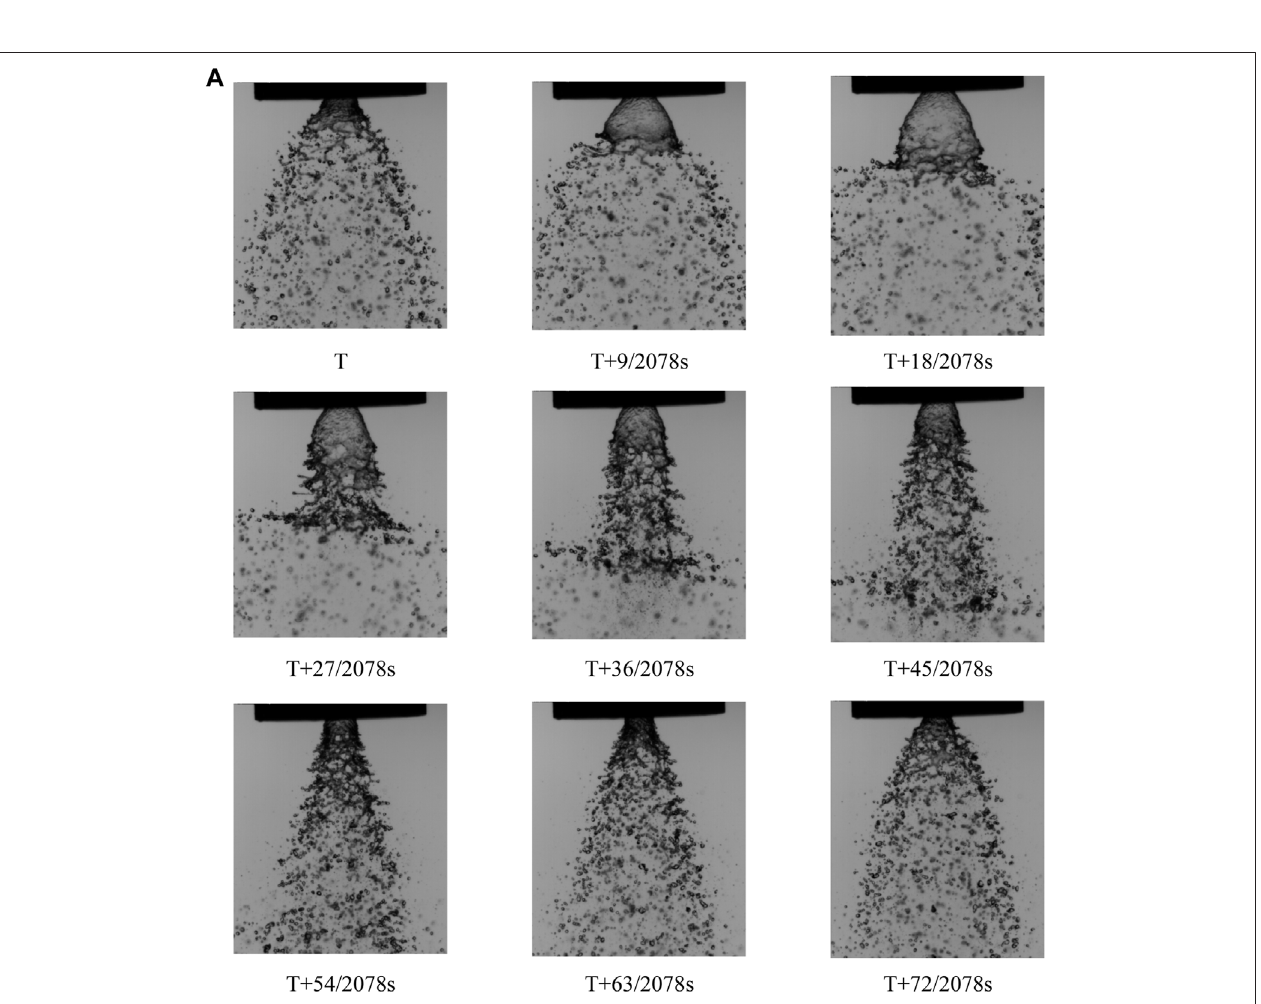
Frontiers in Energy Research |